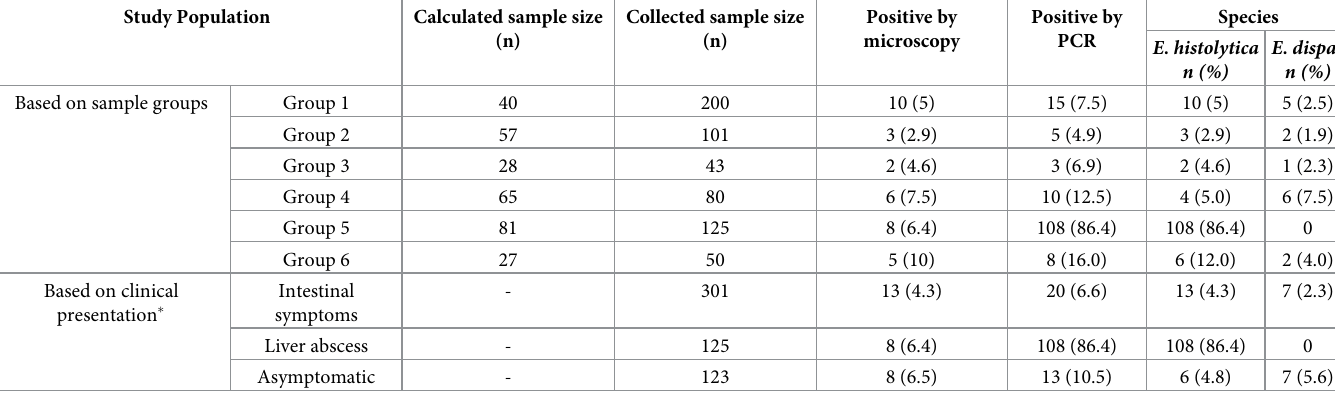
Table 1. Distribution of Entamoeba species in different study